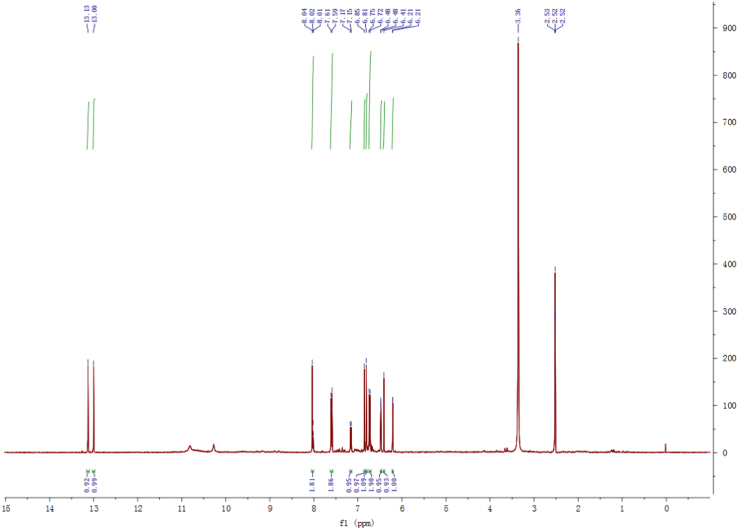
1H-NMR spectrum of compound 12.